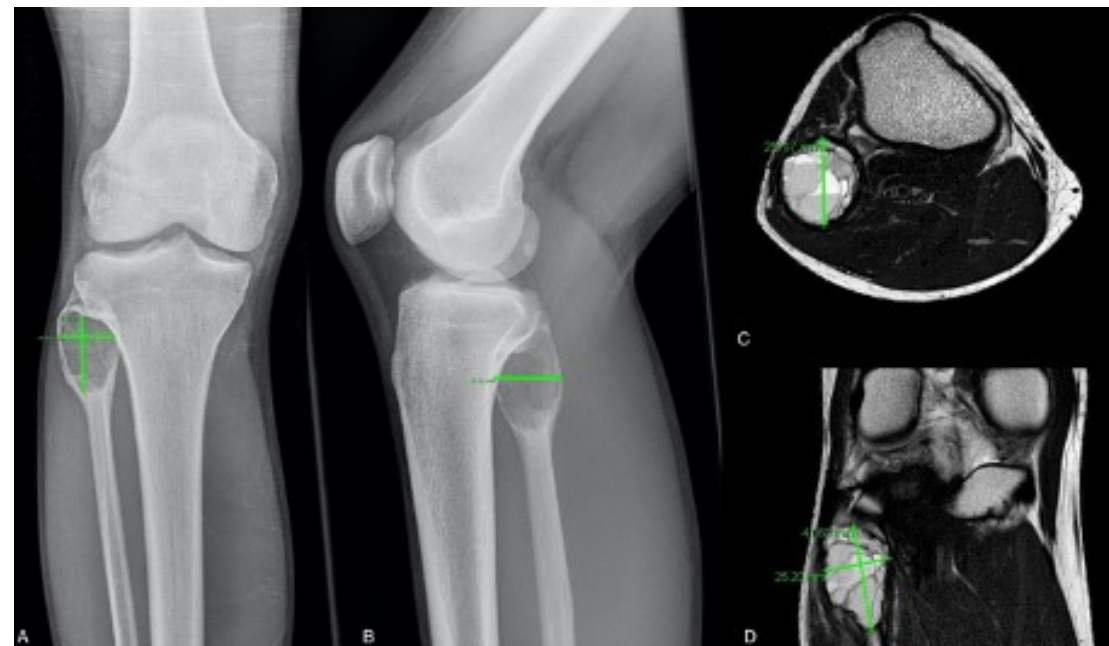
Figure 2. ABC of the proximal fibula of an 18-year-old patient—left: measurement of the cyst diameter in a.p. ( A ) and lateral ( B ) radiograph and in transversal ( C ) and coronar ( D ) MRI scan.